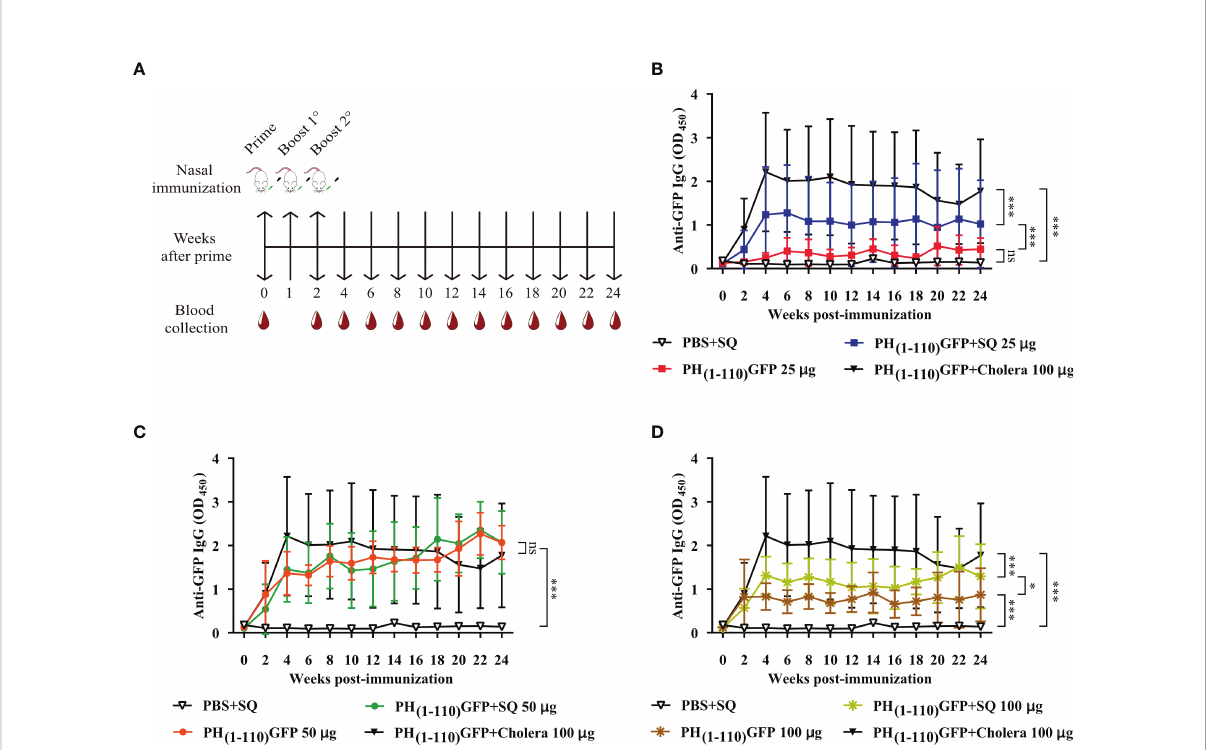
FIGURE 2 Comparison of IgG antibody response after intranasal administration of PH (1-110) GFP NPs at different concentrations with and without adjuvant. (A) Schematic timeline of immunizations and bleeds of BALB/c mice. The immunization schedule included three doses and bleeds at